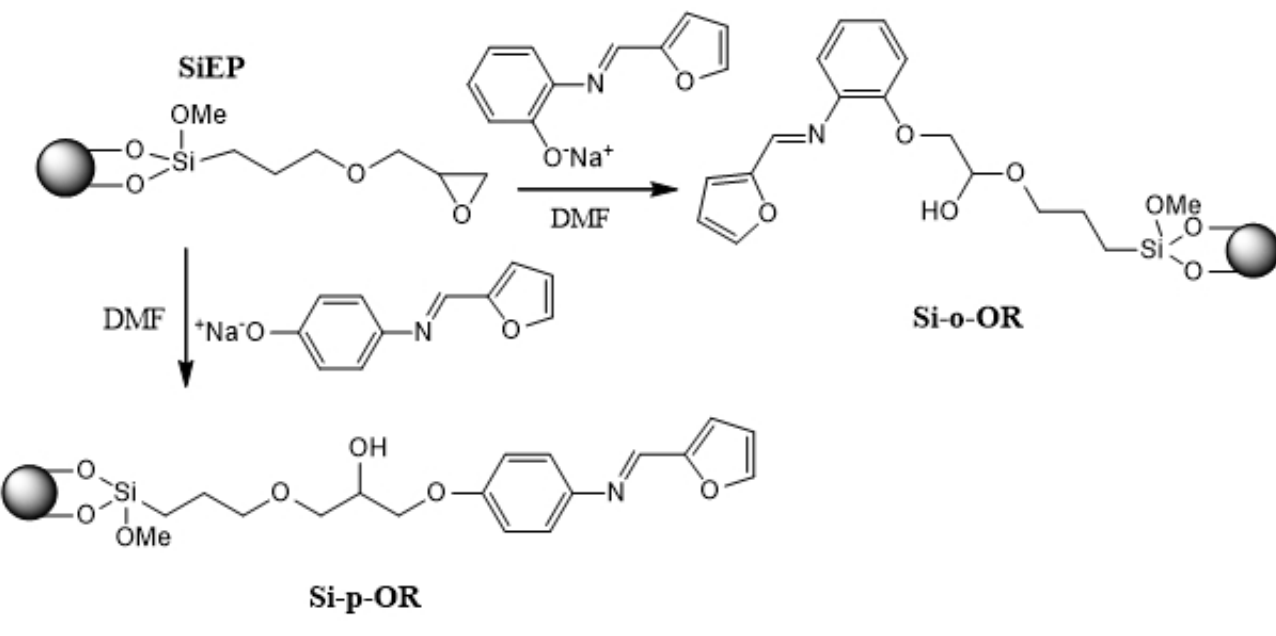
Scheme 1. Synthesis route of Si-p-OR and Si-o-OR